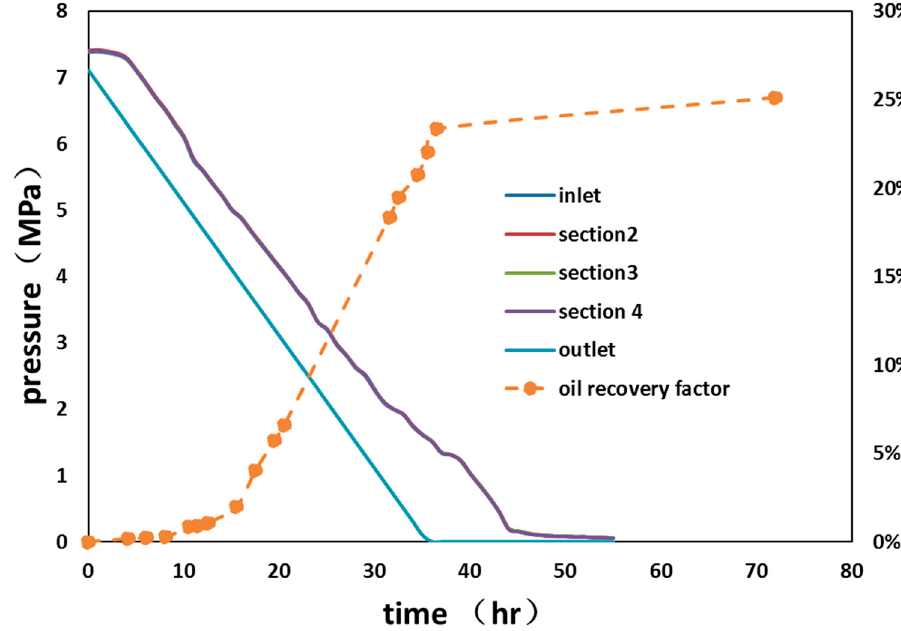
Figure 12. Relationship between pressure changes and oil recovery of Experiment 5.